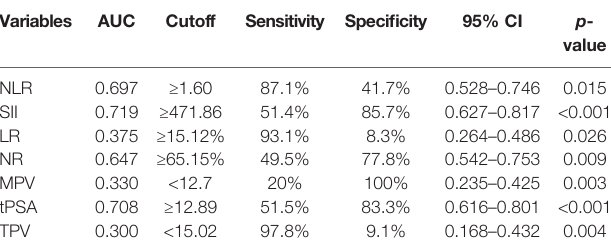
TABLE 2 | Cutoff, AUC, sensitivity, and speci fi city values of NLR, SII, LR, NR, MPV, tPSA, and TPV.